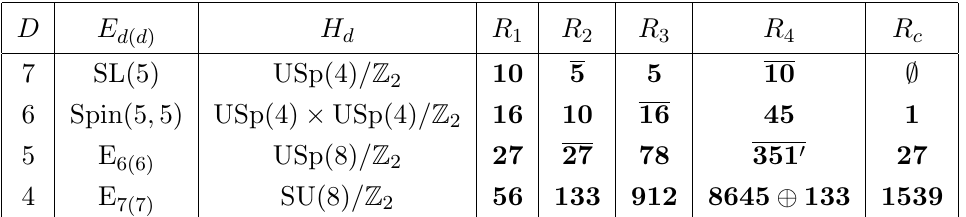
Table 1 . The split real form of the exceptional groups, their maximal compact subgroups and representations appearing in the tensor hierarchy, as well as the additional representation R c used to define a certain purity condition required later in the definition of half-maximal